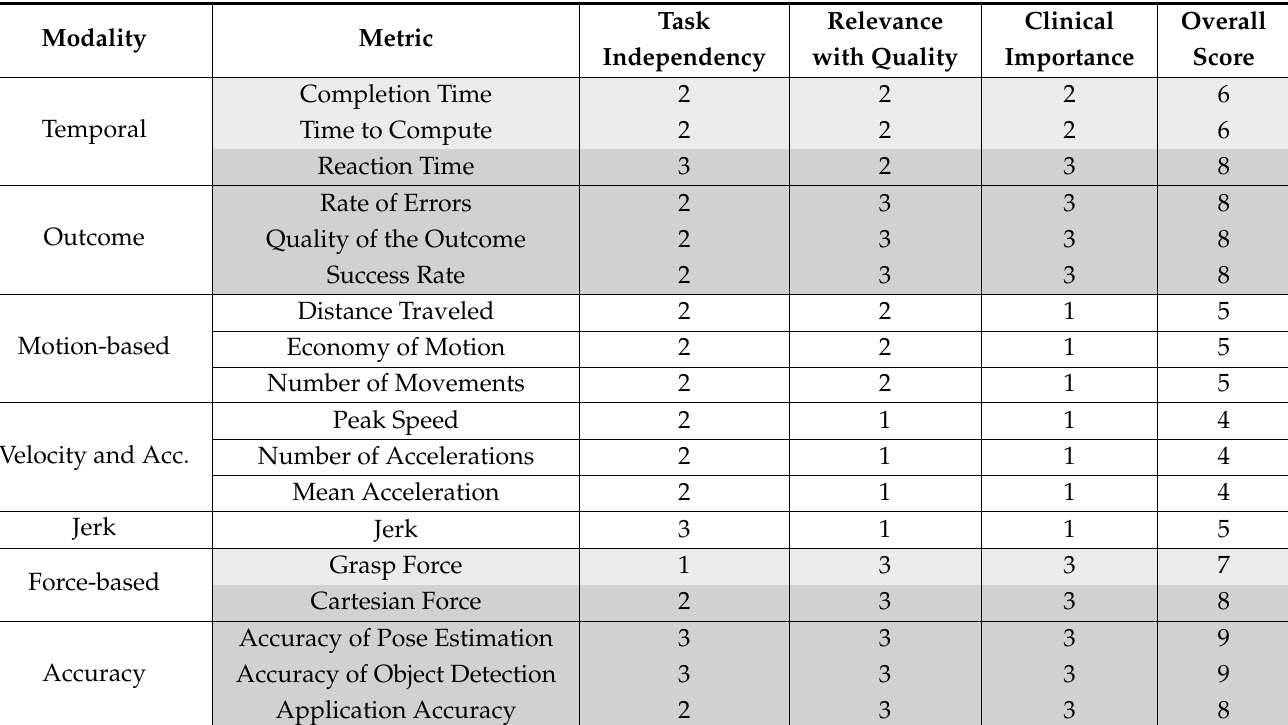
Table 1. Characteristic performance evaluation and comparison metrics for RAMIS subtask au- tomation, grouped by modality. The metrics are scored in three aspects on a scale of 1–3: